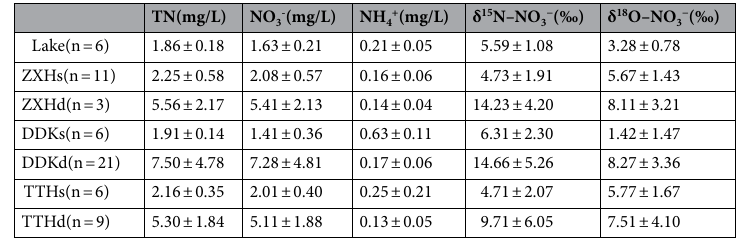
Table 1. Hydrochemical parameters of Shengjin Lake basin in April